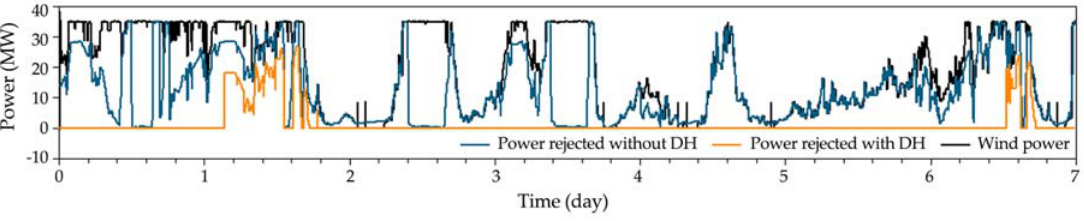
Figure 10. Simulation results of the rejected wind power with and without district heating (DH).